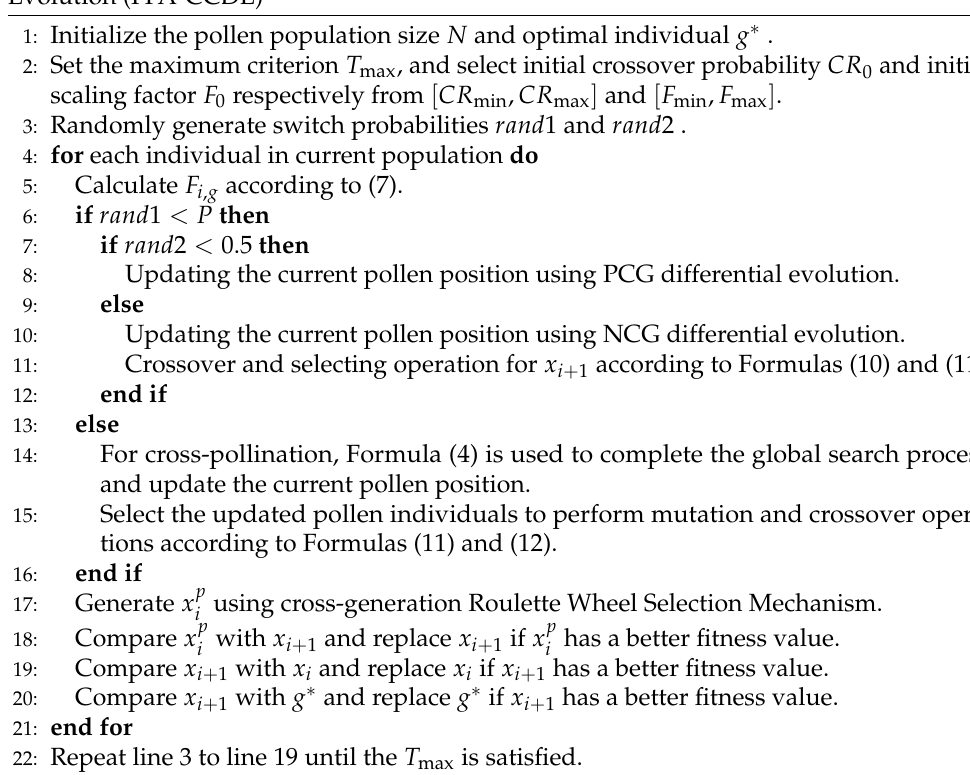
Algorithm 1 Flower Pollination Algorithm Based on Cosine Cross-Generation Differential Evolution